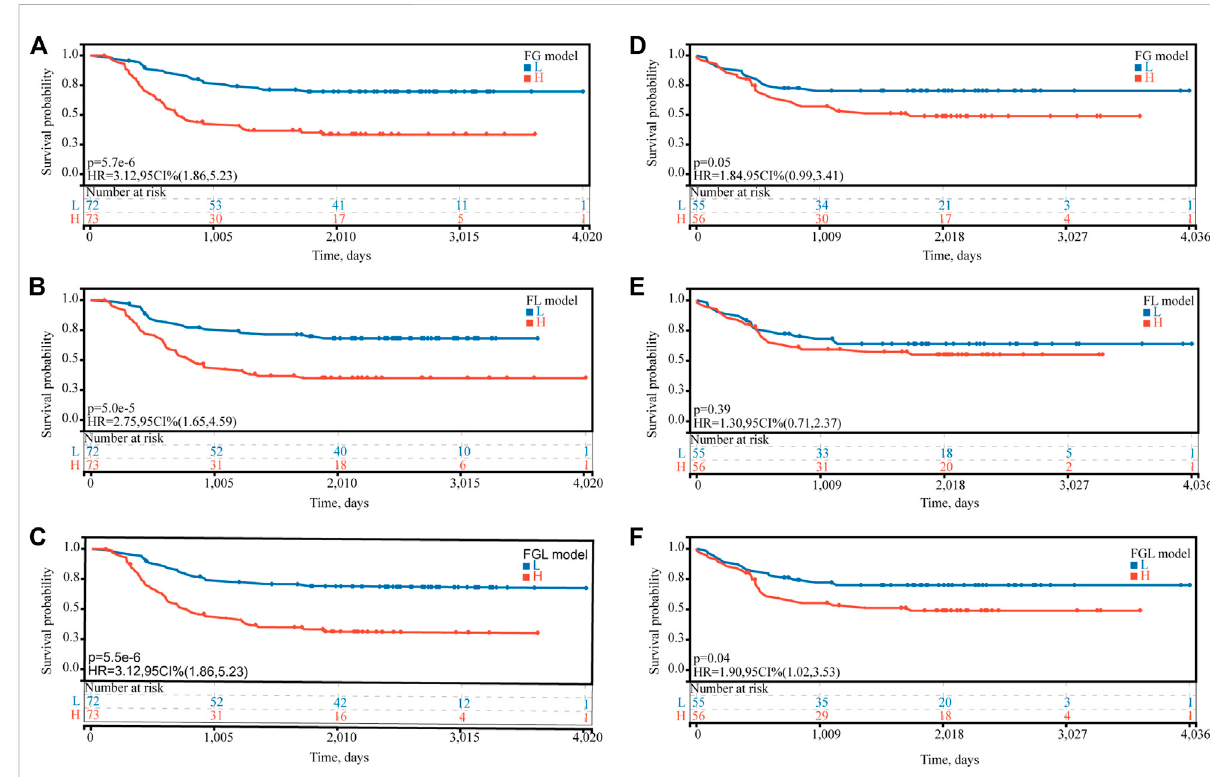
FIGURE 2 Predictive ability of the FG, FL, and FGL prognostic model for the prognosis of P-AML. Based on the median risk score of (A , D) FG, (B , E) FL, and (C , F) FGL models, patients were divided into the high-risk group and the low-risk group. (A,B,C) Kaplan – Meier curve of the high-risk and low-risk groups of the TARGET-discovery cohort. (D,F) Kaplan – Meier curve of the high-risk and low-risk groups of the TARGET-validation